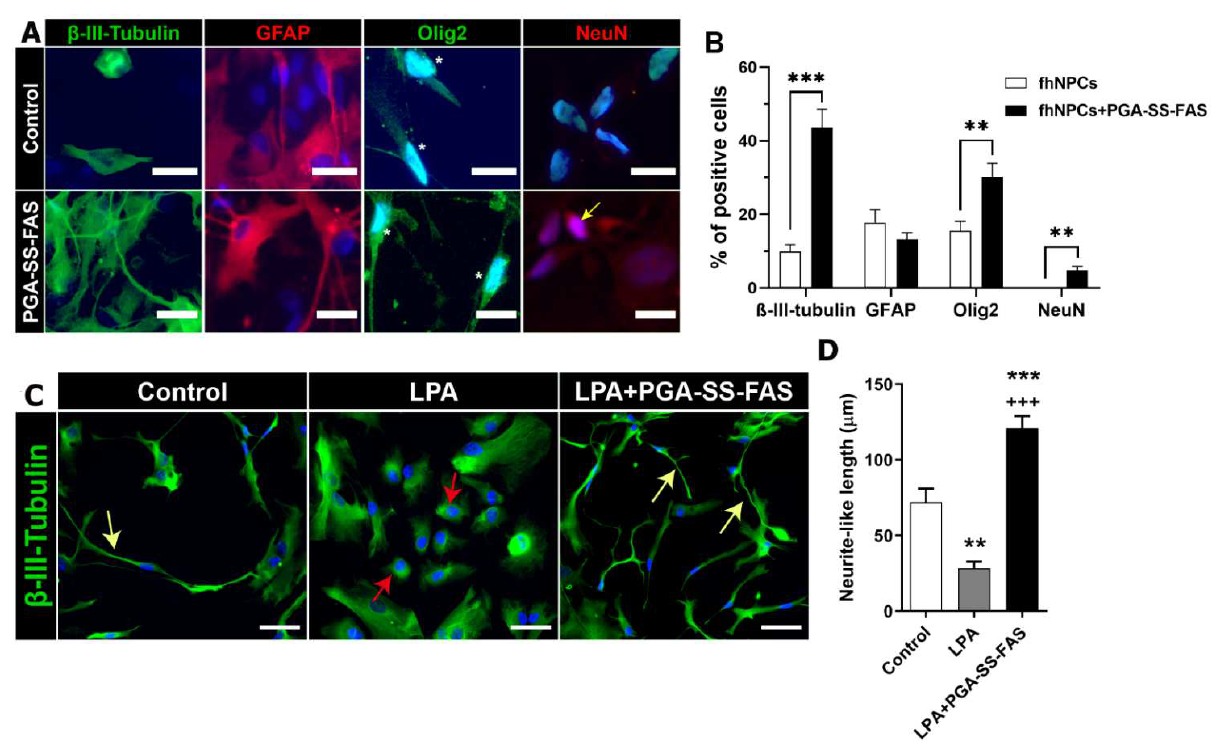
Figure 3. PGA-SS-FAS priming process enhances neuronal and oligodendrocyte differentiation and induces neurite outgrowth in a model of neurite retraction. ( A ) Representative immunofluorescence images of hfNPCs using β -III-tubulin for immature neurons (green), GFAP for astrocytes (red), Olig2 for oligodendrocytes (green), NeuN for mature neurons (red), and DAPI (blue) (scale bar = 20 μm) (positive nuclear staining is indicated with an arrow) in the presence of the PGA-SS-FAS compound for inducing the priming process (PGA-SS-FAS) or its vehicle (control). ( B ) Quantification of the percentage of positive cells for each of the indicated cell markers with (black bars) or without (white bars) 24 h PGA-SS-FAS priming. Data presented as the mean ± SEM determined by Student’s unpaired t-test ( n = 3). ** p < 0.01, *** p < 0.001 vs. hfNPCs. ( C ) Representative immunofluorescence images of β -III-tubulin (green) and DAPI (blue) staining during the in vitro neurite retraction assay induced by lysophosphatidic acid (LPA) treatment during 24 h in hfNPC adherent cultures. Yellow arrows indicate neurite-like processes emanating from neuronal progenitors in the control condition (in the absence of LPA) and in co-treated cultures (LPA + PGA-SS-FAS); red arrows indicate rounded cells 24 h after LPA treatment and induced neurite-like retraction (scale bar = 50 μm). ( D ) Neurite length quantification presented as the mean ± SEM determined by one-way ANOVA with the Tukey multiple comparison test ( n = 3). ** p < 0.01, *** p < 0.001 vs. control; +++ p < 0.001 vs. control.